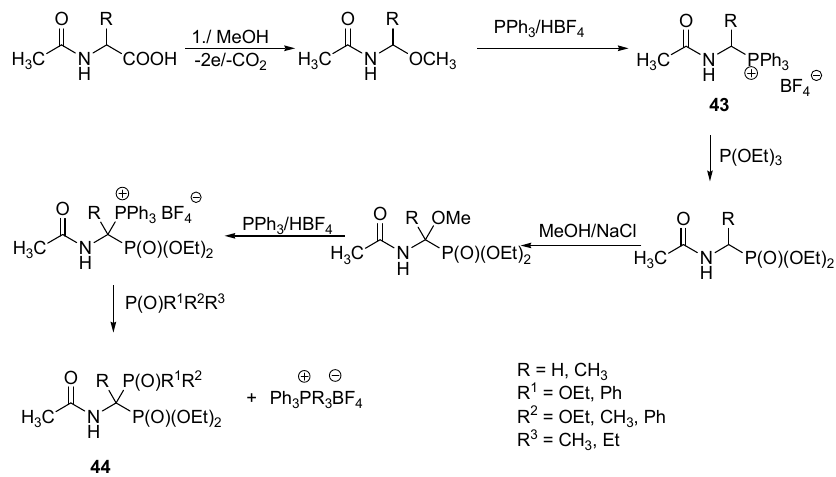
Scheme 22. Transformation of diethyl 1-( N -acetylamino)-1-alkylphosphonates into bisphosphoric acid esters via the corresponding phosphonium